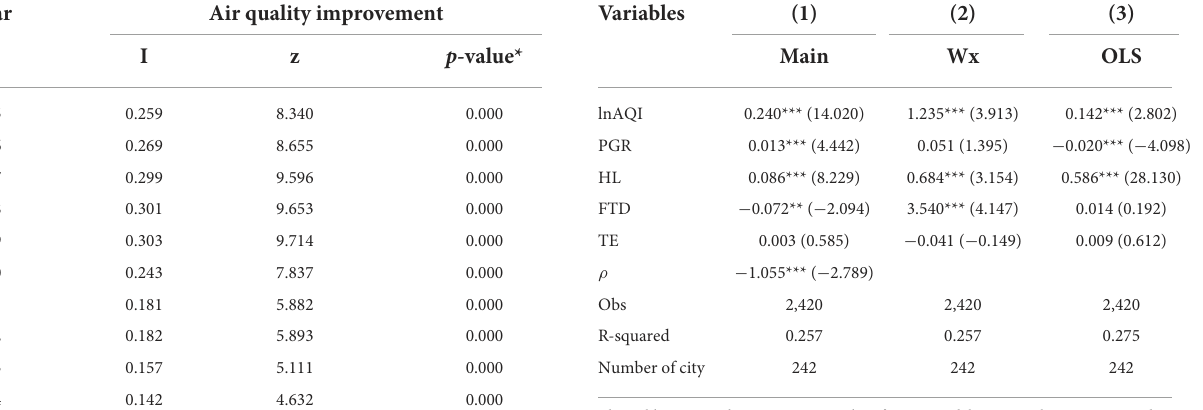
TABLE 2 Air quality improvement Moran index.